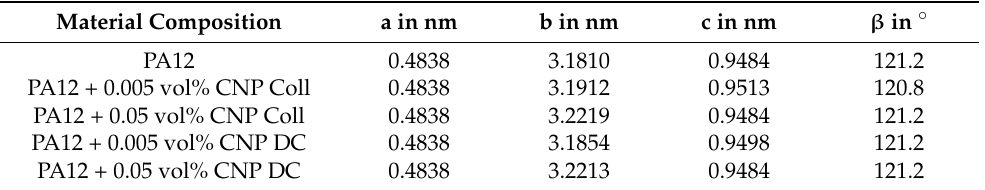
Figure 9. Diffraction patterns of PA12 powder and specimens of different compositions additivated by colloidal deposition and dry coating, depicted ( a ) as overviews separated from each other and ( b ) on top of each other with a zoomed-in picture of the shifted main reflex positions. Table 2. Unit cell parameters for the monoclinic gamma PA12 phase as determined from Rietveld refinements of the diffraction pattern of processed specimens.